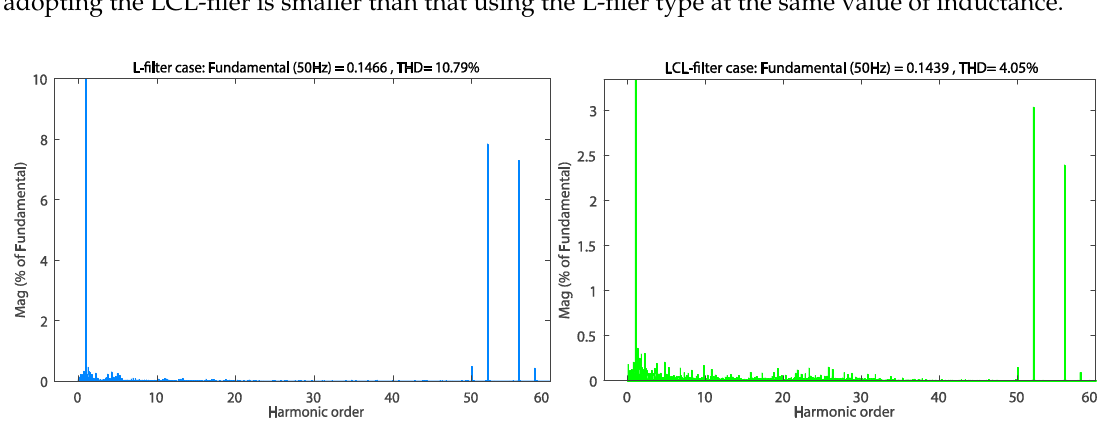
Figure 11. Bode plot of the open loop grid current loop: with and without passive damping based technical optimum tuning.